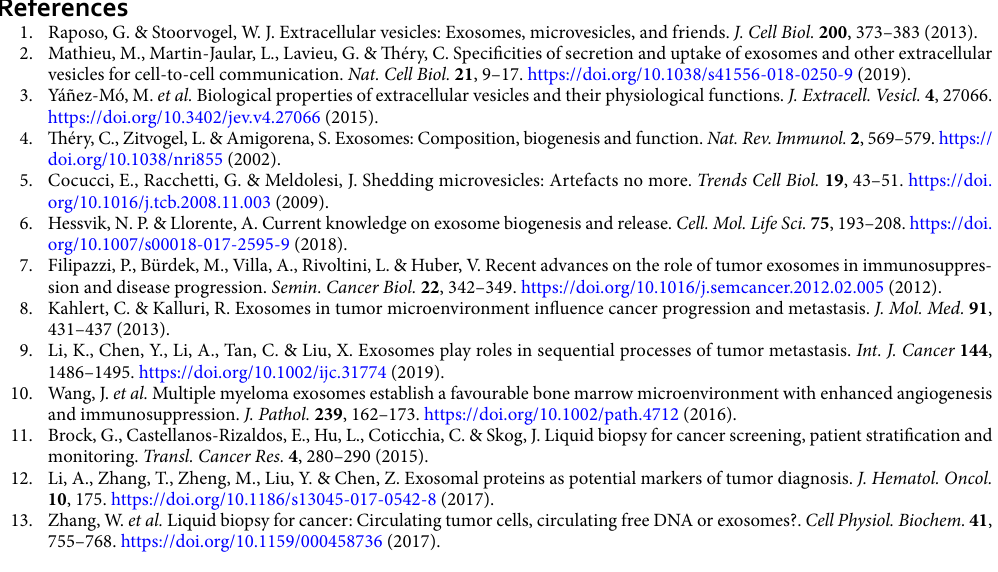
Figure 6. Characterization of tEVs isolated breast cancer (BC) patient serum using iSUF. ( A ) Left. Characteristic fluorescence images of HER2, CD24, miR21, CD63, and CD9 expression on isolated EVs immobilized on magnetic beads from BC patients and healthy donors. Right. Fluorescence intensity histograms of HER2, CD24, miR21, CD63, and CD9 of isolated EVs for BC patients (n = 10) and healthy donors (n = 14). ( B ) Total fluorescence intensity quantification of HER2, CD24, miR21, CD63, and CD9 expression level on isolated EVs from BC patients and healthy donors. Patients demonstrated higher expression levels of HER2, CD24, and miR21 than healthy donors ( p < 0.05). Patients and HDs demonstrated similar expression level of CD63 and CD9 ( p > 0.05). P patient; H healthy